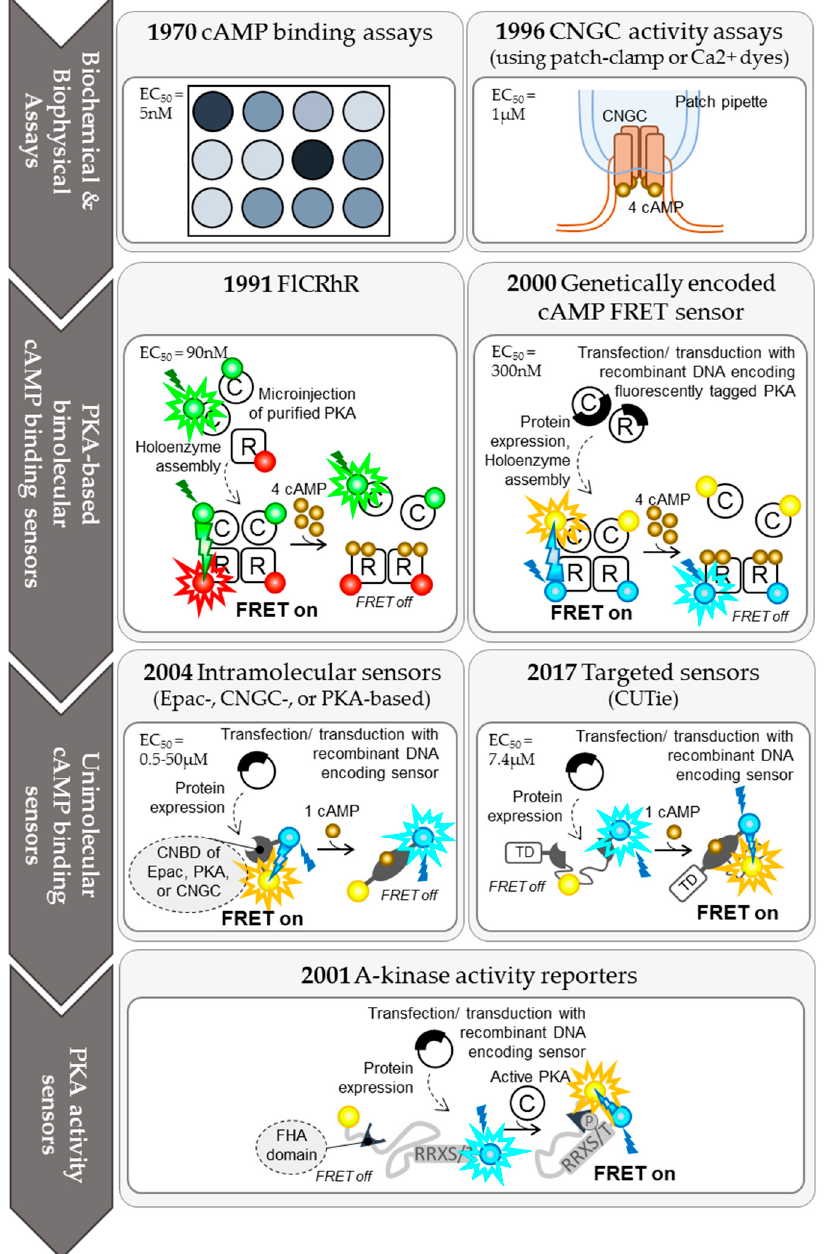
Figure 1. Evolution of cardiac cAMP detection from bulk biochemical analysis to targeted real-time imaging in living cardiomyocytes. In all panels, cAMP molecules are represented by golden spheres; fluorophore molecules are represented by coloured spheres, with the colours indicating their emission spectra. Exposure to light with the excitation spectrum of a fluorophore is represented by a monochrome lightning bolt; emission of fluorescent light is represented by a halo around the fluorophore. Fluorescence transfer is represented by a lightning bolt that originates from the fluorescence donor, which matches the donor in colour and points towards the fluorescence acceptor. EC 50 for cAMP is indicated for all cAMP detection systems, as reported in the literature [10– 13].